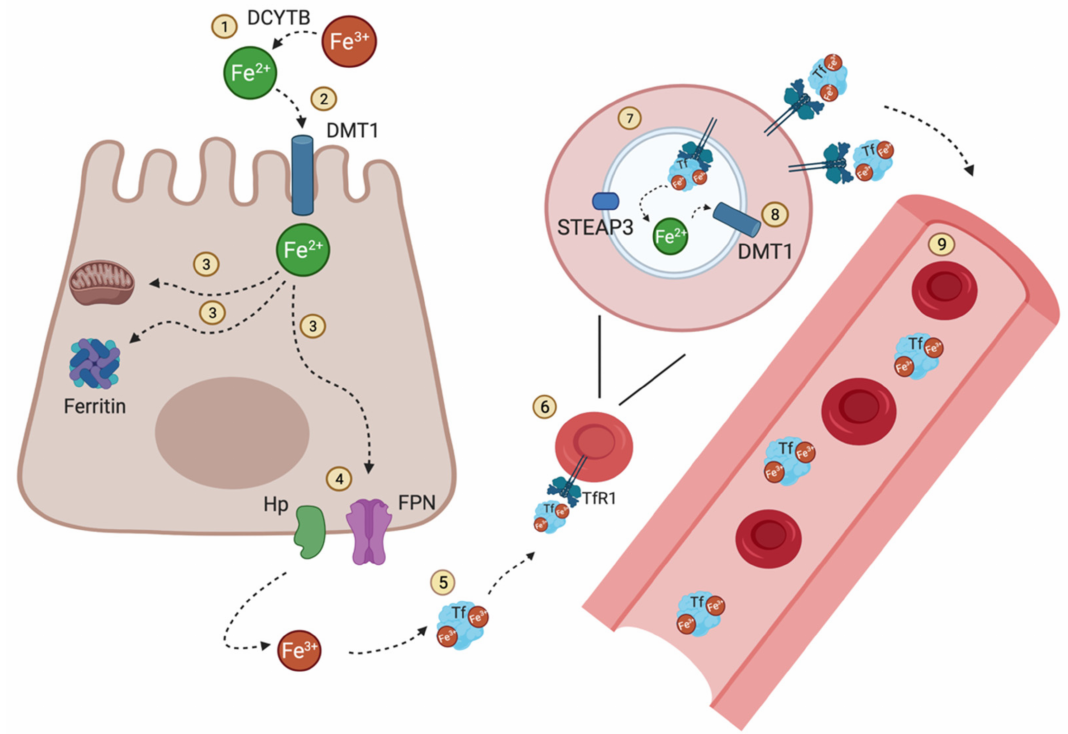
Figure 1. Iron distribution and circulation. Nonheme dietary iron Fe 3+ is reduced to Fe 2+ by the iron reducing DCYTB ( 1 ) prior to its uptake at the apical membrane of enterocytes via DMT1( 2 ). Fe 2+ can then be directly used for intracellular mechanisms, stored when bound to ferritin or released directly into the circulation ( 3 ). ( 4 ) Therefore, reduced iron Fe 2+ is transported by ferroportin (FPN), the only known iron exporter so far, and then oxidized by hephaestin Hp to be then bound to Tf ( 5 ). Most of the iron present in the circulation is bound to Tf. As a result, erythrocyte precursors (erythroblasts) take up this transferrin-bound iron via TfR1( 6 ). Fe 3+ bound to transferrin is reduced in the endosome by ferrireductase STEAP3 to Fe 2+ ( 7 ) where it is exported via DMT1 ( 8 ) into the cytosol and enters the labile iron pool. Mature RBCs circulate in the blood for around 120 days ( 9 ) until they are removed from the circulation during erythrophagocytosis. The illustration was created using BioRender.com, (accessed on 3 April